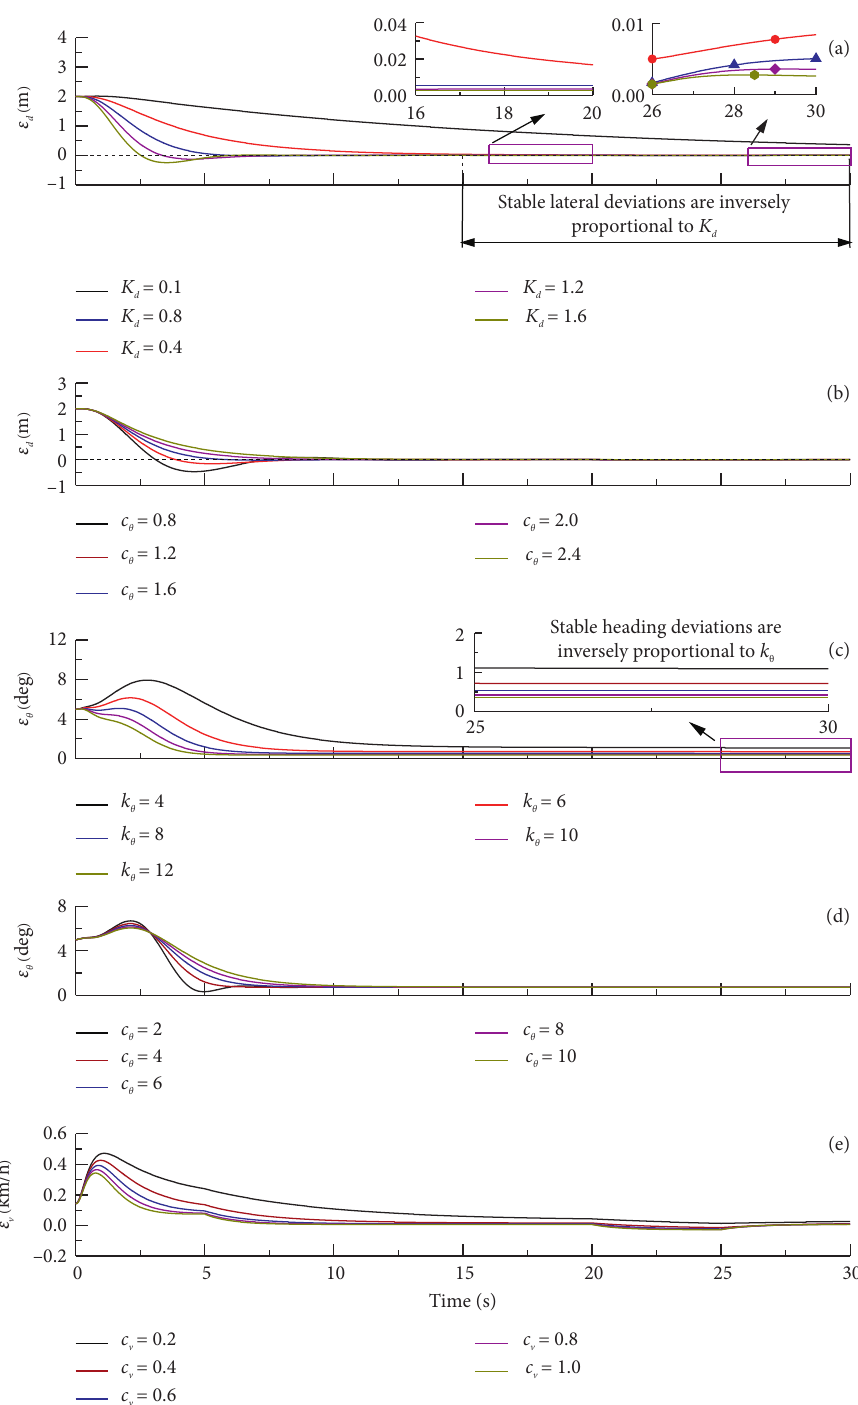
Figure 13: Effects of control parameters on three deviations of the vehicle in a circular path-following motion: (a) parameter k parameter c d , (c) parameter k θ , (d) parameter c θ , and (e) parameter c v